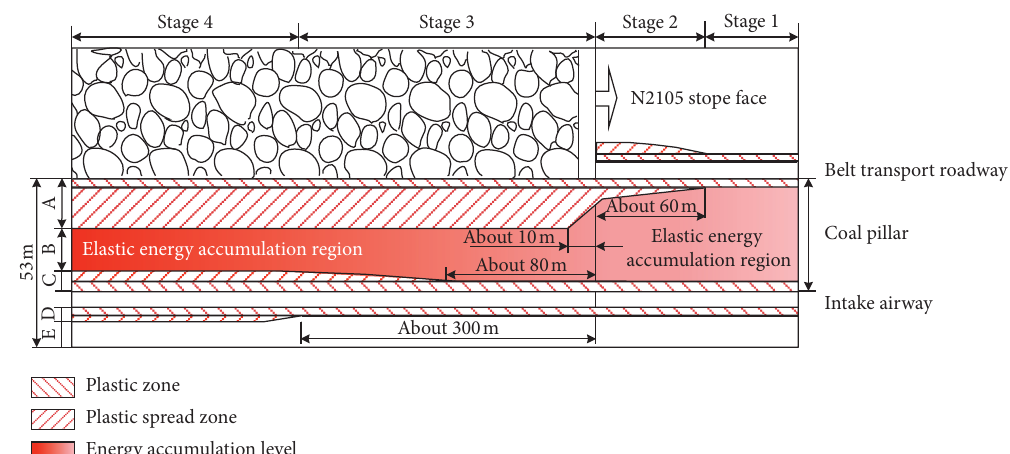
Figure 9: Characteristics of “strike” stage of elastoplastic transformation and stress evolution of coal body.